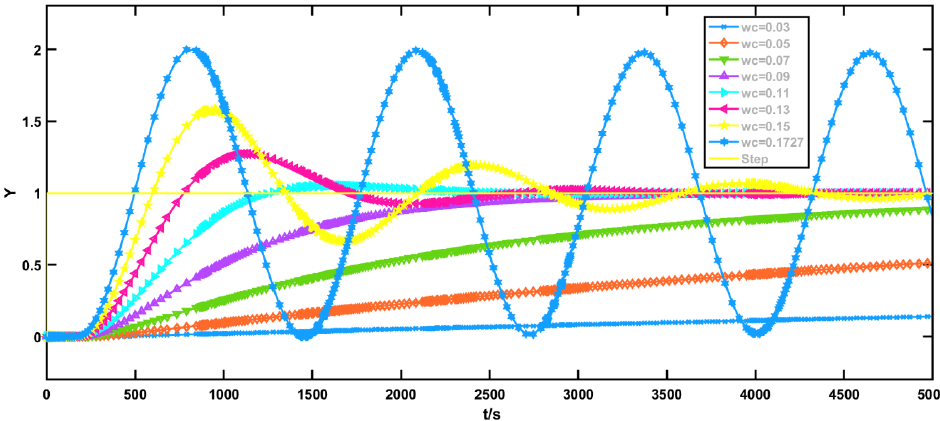
Figure 12. Step Response of a Second-Order Time-Delay System for Different 𝜔 (cid:3030) When 𝐾 = 5 .